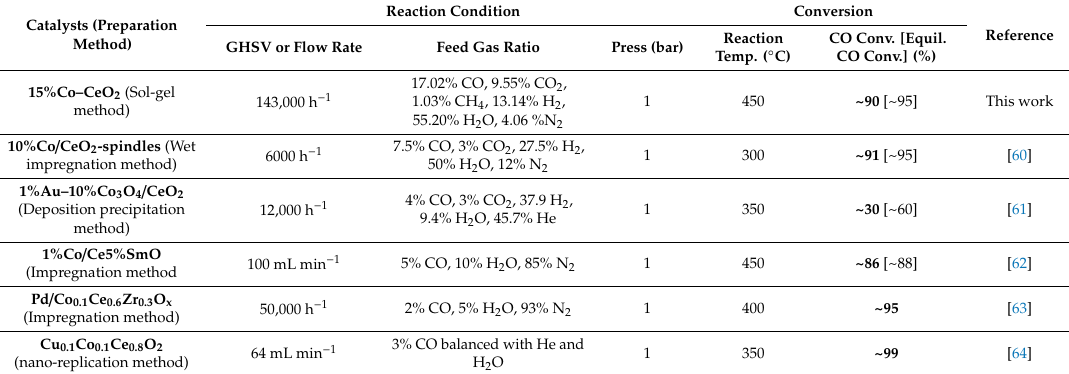
Table 2. Comparative results of Co and Ce based catalysts for the high-temperature shift